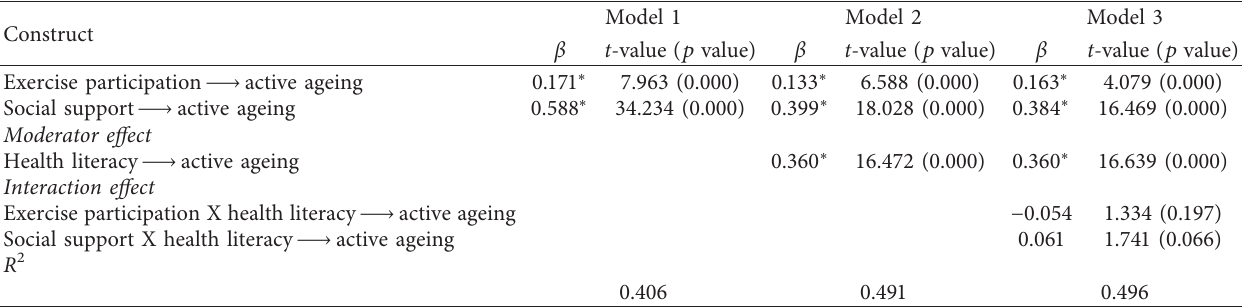
Figure 2: Path coefficients for the research model (including interaction effect). Value on path: standardized coefficients ( β ); R 2 : coefficient of determination; ∗ p < 0 . Table 3: Estimation results for hypotheses.